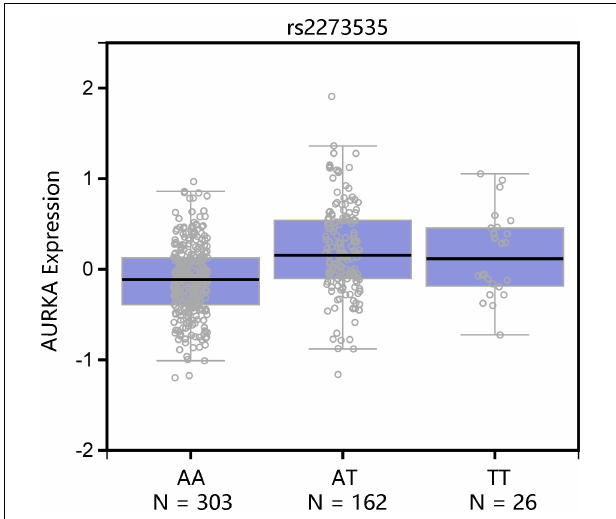
FIGURE 5 | Functional implication of AURKA rs2273535 polymorphism. The genotype of rs2273535 polymorphism and expression of AURKA gene in transformed muscle tissue was based on the public GTEx portal database.